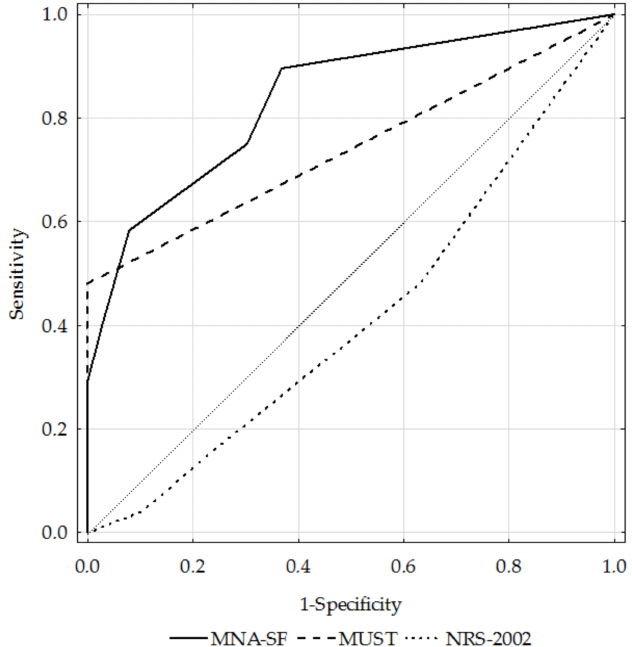
Figure 4. ROC curves for the MNA-SF, MUST, and NRS-2002 questionnaires against the GLIM criteria in the total study population.Notes: MNA-SF, Mini Nutritional Assessment—Short Form; MUST, Malnutrition Universal Screening Tool; NRS-2002, Nutritional Risk Score.